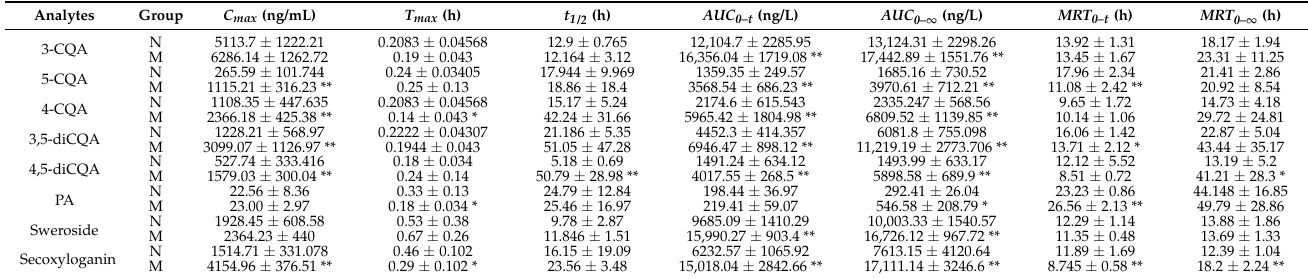
Figure 4. Mean concentration–time curves of the eight compounds in N (normal rats group) and M (liver injury model rat group) rat plasma after oral administration of the LJF aqueous extract. Values are presented as mean ± SD of 6 rats. Table 6. Pharmacokinetic parameters of the eight compounds after oral administration of LJF extract in rats (mean ± standard deviation, n =